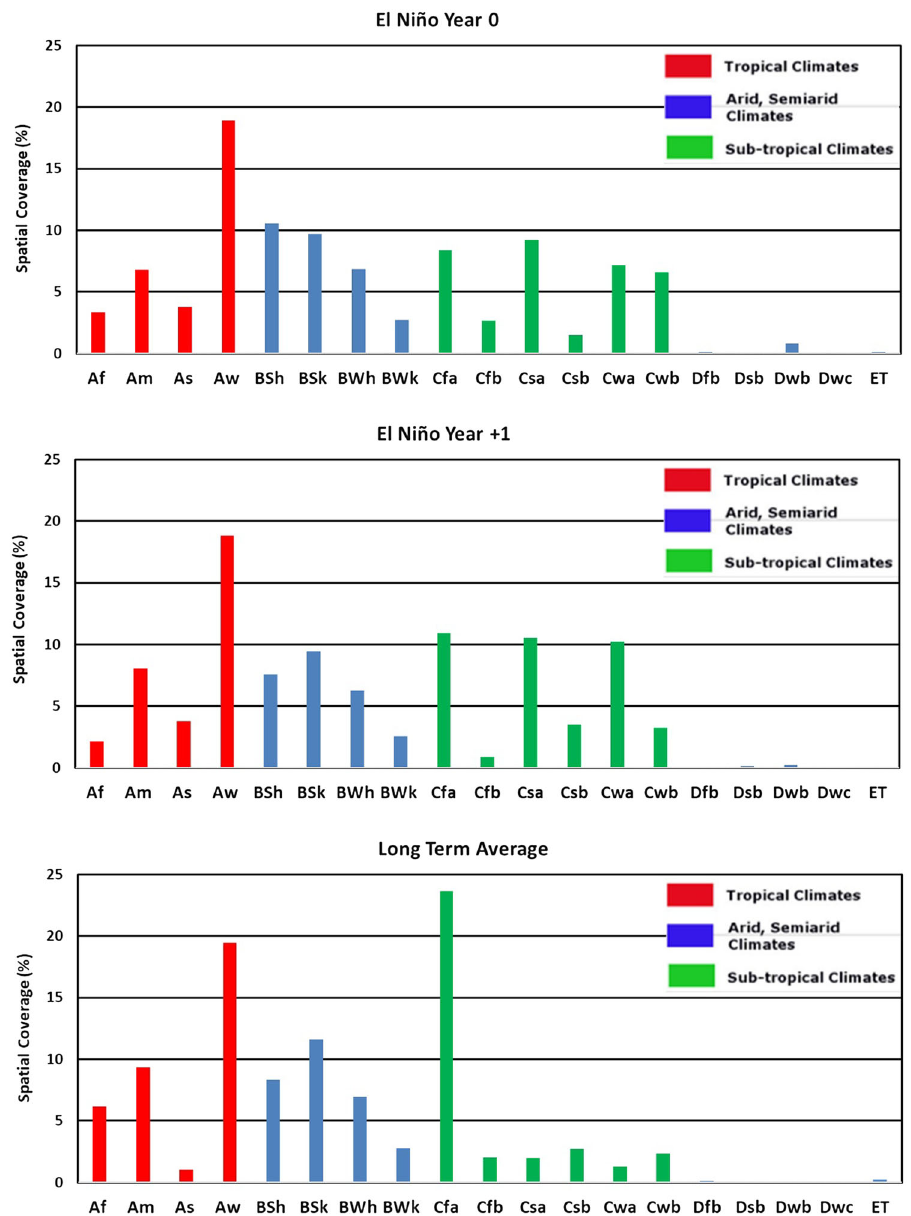
Fig. 3 Average spatial coverage distribution of Ko¨ppen–Geiger subtypes for El Nin˜o Year 0 (top panel), El Nin˜o Year ? 1 (middle panel), and long-term average (bottom